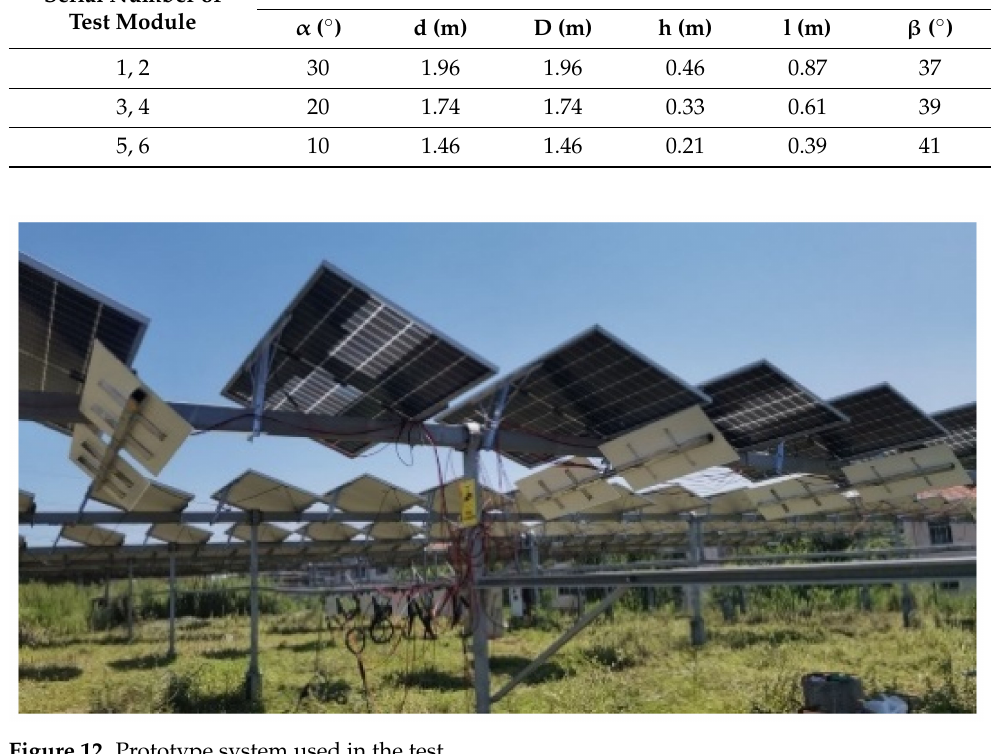
Figure 12. Prototype system used in the